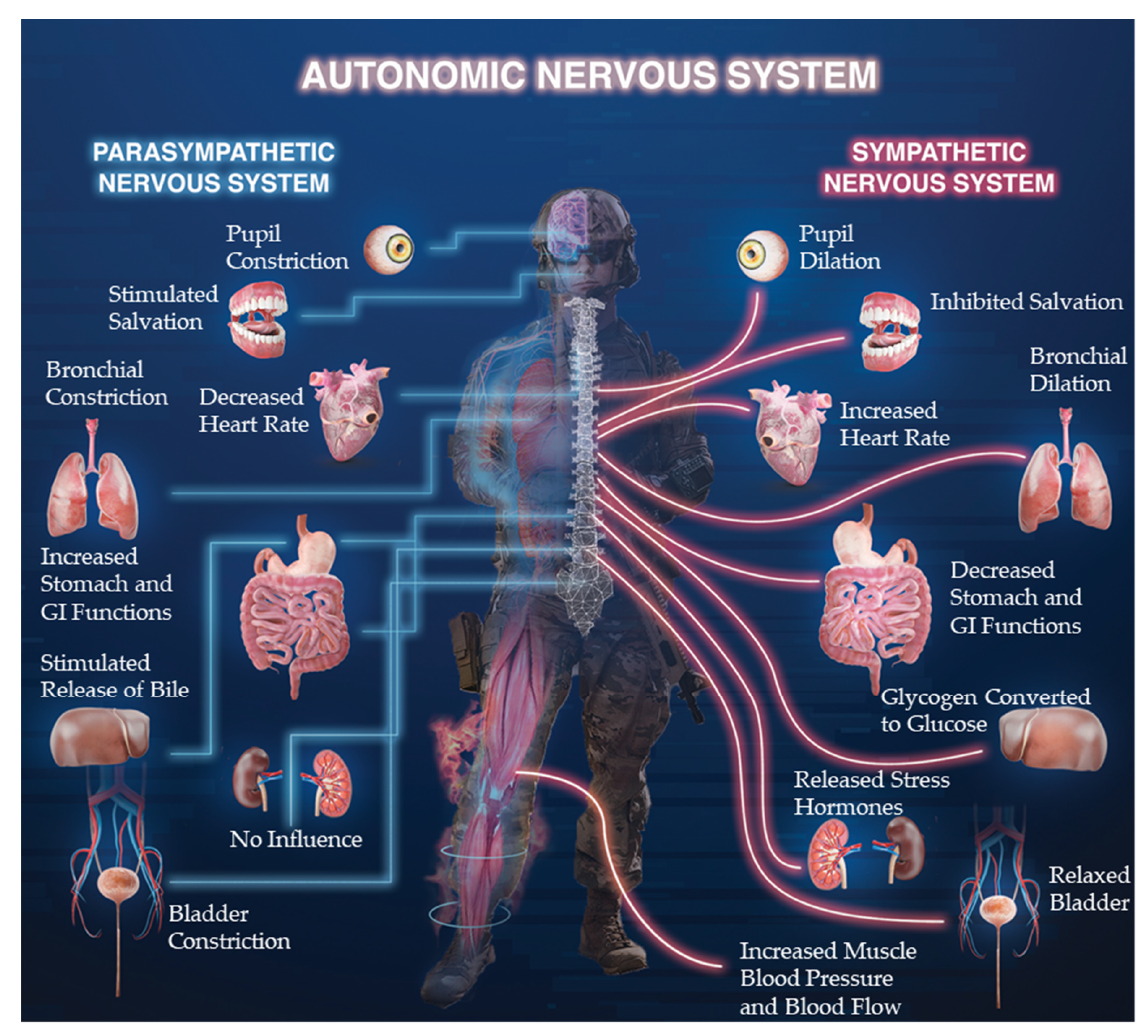
Figure 1. Example layout of the relations between various organs throughout the body and the Autonomic Nervous Sys- tem.